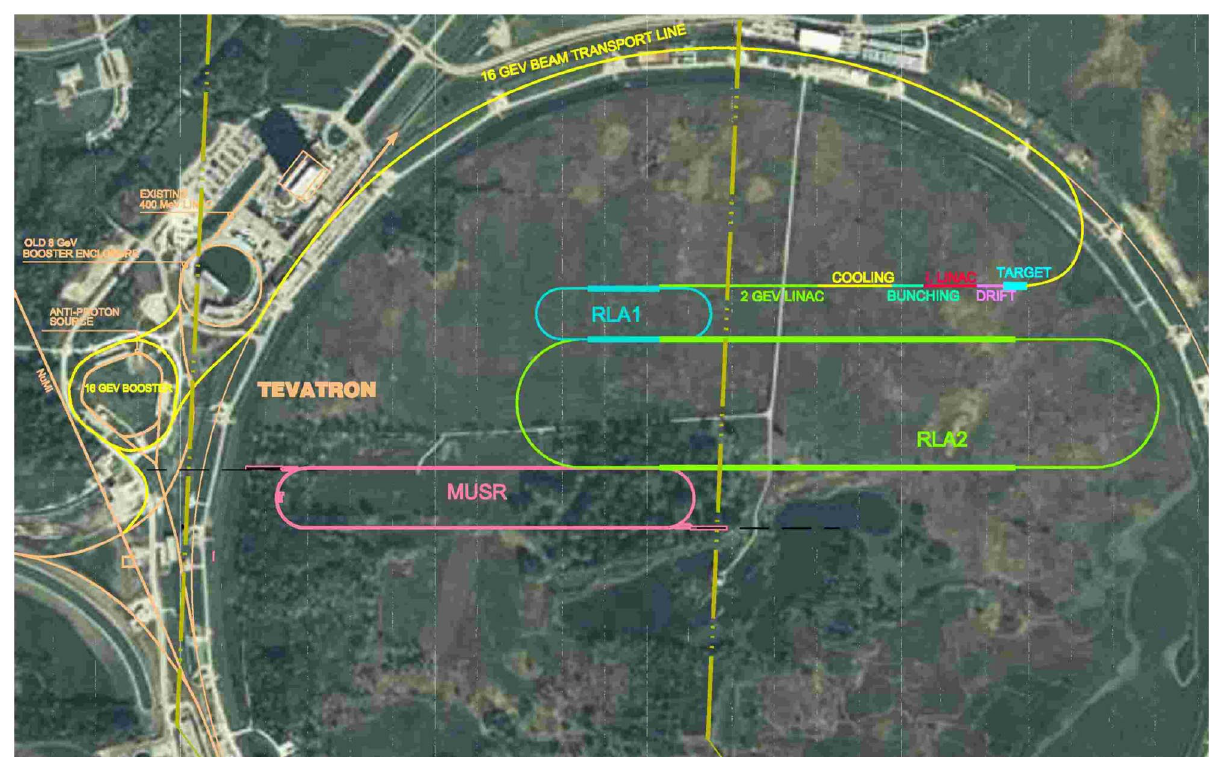
FIG. 28. (Color) Schematic of a 50 GeV neutrino factory at Fermilab.